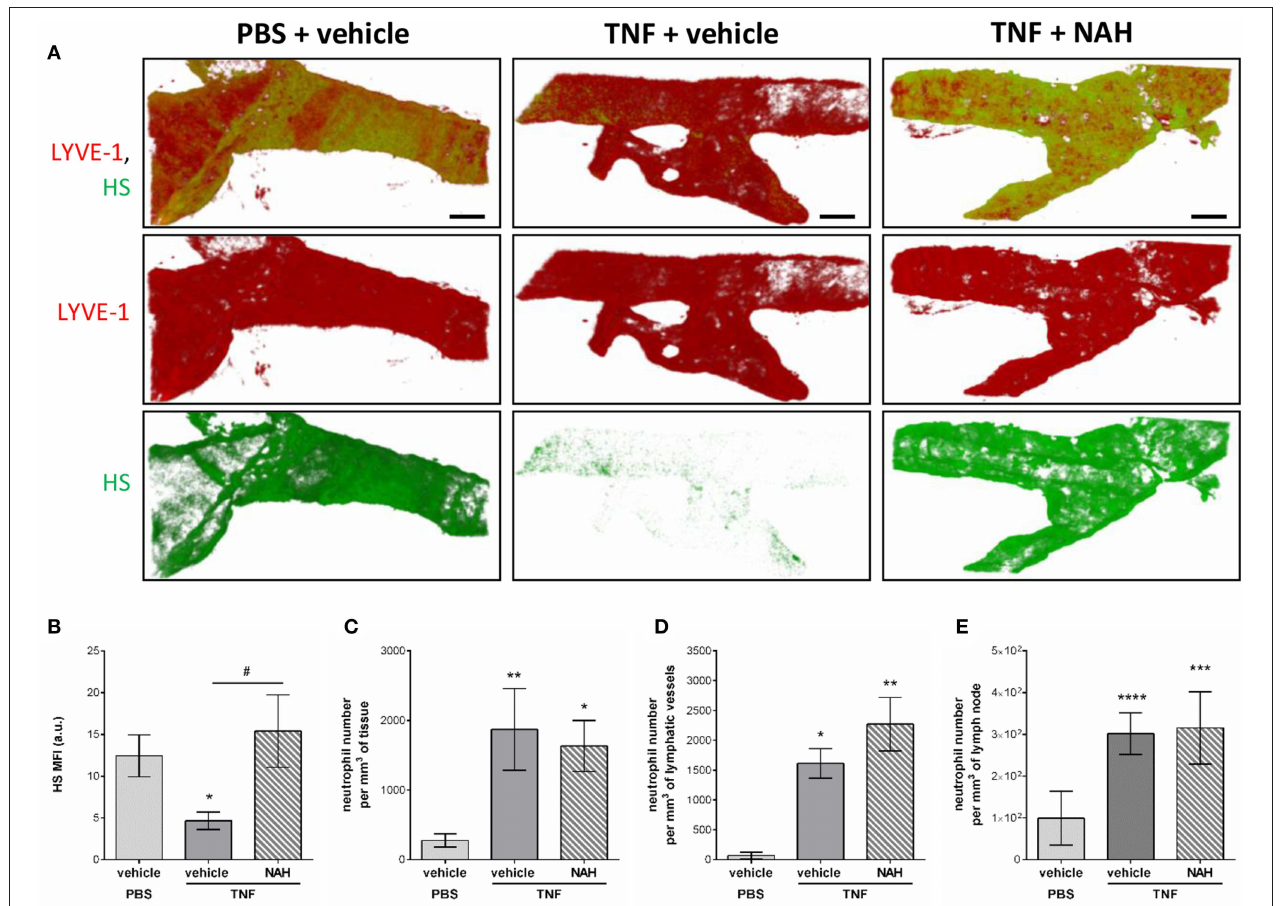
FIGURE 8 | Effect of a non-anticoagulant heparanase inhibitor (NAH) on TNF-induced HS remodeling of the lymphatic glycocalyx and neutrophil migration responses. TNF (300 ng) or PBS (as control) were administrated intrascrotally (i.s.). Three hours later, mice received an i.s. injection of 50 µ g of non-anticoagulant heparanase inhibitor N-desulfated/re-N-acetylated heparin (NAH) or vehicle. At 14h post-TNF-stimulation, mice were further i.s injected with anti-HS (green) and anti-LYVE-1 (red) mAbs to label in vivo and visualize the heparan sulfate layer and lymphatic vasculature, respectively. Sixteen hours post-TNF-stimulation, animals were sacrificed, their cremaster tissues and draining (i.e. inguinal) lymph nodes harvested and prepared for confocal microscopy to measure HS remodeling on tissue-associated initial lymphatic vessels and neutrophil migration responses. (A) The images show representative 3D-reconstructed confocal images of an initial lymphatic vessel from a PBS (left hand side panels) or TNF (middle and right-hand side panels)-stimulated tissues with or without NAH-pre-treatment ( N = 3–6 mice per group; Bars = 50 µ m). (B) Quantification of the Mean Fluorescence Intensity (MFI) of HS expression on initial lymphatic vessels of the cremaster muscles ( N = 3–6 mice per group). (C) Quantification of the number of neutrophils present into the tissue’s interstitium (per mm 3 of tissue) ( N = 6–14 mice per group). (D) Quantification of the number of neutrophils present within initial lymphatic vessels (per mm 3 of lymphatic vessel) ( N = 5–10 mice per group). (E) Quantification of the number of neutrophils present in the draining lymph nodes of the cremaster muscles (per mm 3 of lymph node) ( N = 3 mice per group with two dLNs per animals). Statistical significance between PBS and TNF stimulated groups are indicated by asterisks: * P < 0.05, ** P < 0.01, *** P < 0.001, **** P < 0.0001. Statistical significance between vehicle and NAH-treated groups are indicated by hash symbol: # P <